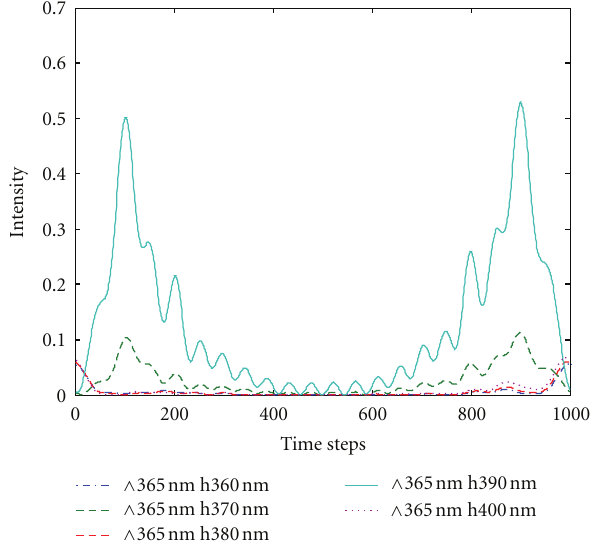
Figure 6: Energy flow of silver film (of di ff erent thicknesses) with a double-grating structure.